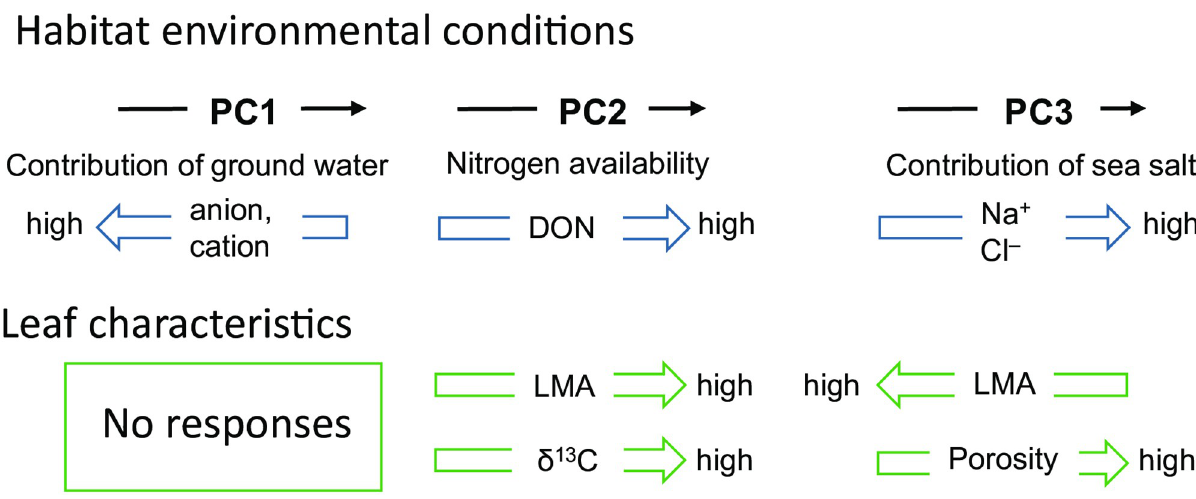
Fig 5. Schematic overview of the relationship between leaf characteristics and habitat environmental conditions.